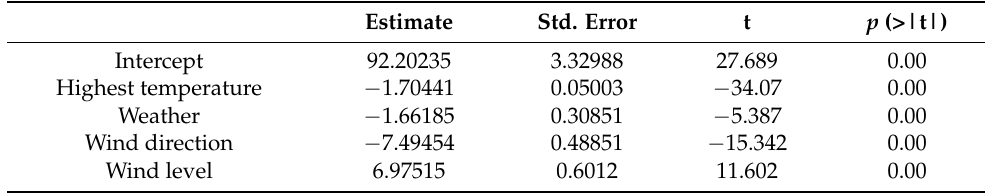
Table 2. The results of multiple regression.